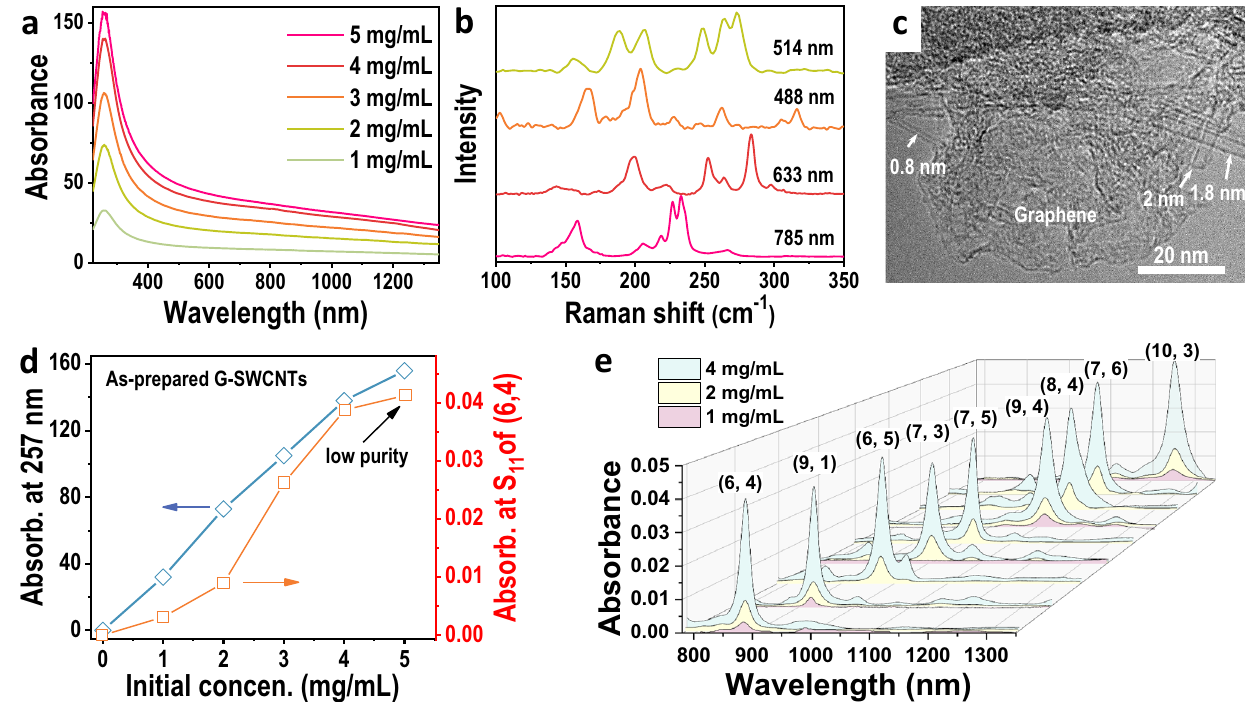
Fig. 3 | Dispersion and structure separation of high-concentration G-SWCNTs. a Optical absorption spectra of as-prepared G-SWCNTs with different concentra- tions. b Raman spectra of raw G-SWCNTs at excitation wavelengths of 514nm, 488nm, 633nm, and 785nm. c TEM imageofraw G-SWCNTscontaining graphene sheetsandSWCNTswithdifferentdiameters. d PlotoftheSWCNTconcentrationin the as-prepared dispersion (blue) and the corresponding yields of (6, 4) SWCNTs (orange) as a function of the initial concentration of G-SWCNTs. The resulting